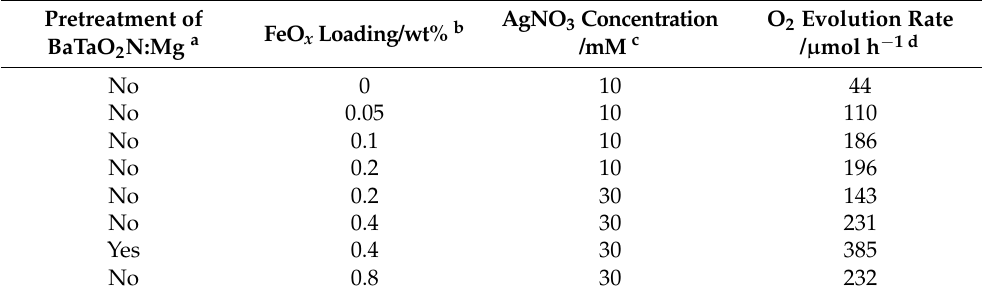
Table 1. The O 2 evolution rates obtained for FeO x /Pt/BaTaO 2 N:Mg under visible light ( λ > 420 nm) using various cocatalyst loading and reaction